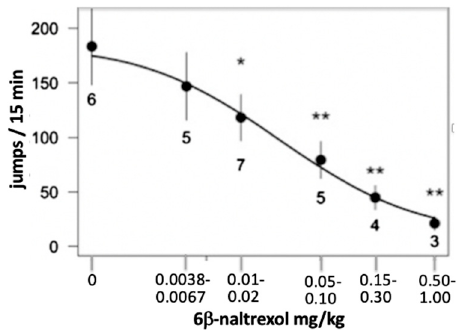
Figure 4. Co-administration (s.c.) of 6BN with morphine daily over 5 days to juvenile mice potently reduces naloxone-induced withdrawal behavior. Morphine injections were started on postnatal day 12 at 10 mg/kg for 3 days, followed by 3 days of 20 mg/kg. Increasing doses of 6BN were co-administered, with the dose doubled when morphine was doubled. On day 6, 30 mg/kg naloxone was injected s.c., and withdrawal jumping was measured. * p , 0.05; and ** p , 0.01 compared to no 6BN (adapted from [42]).